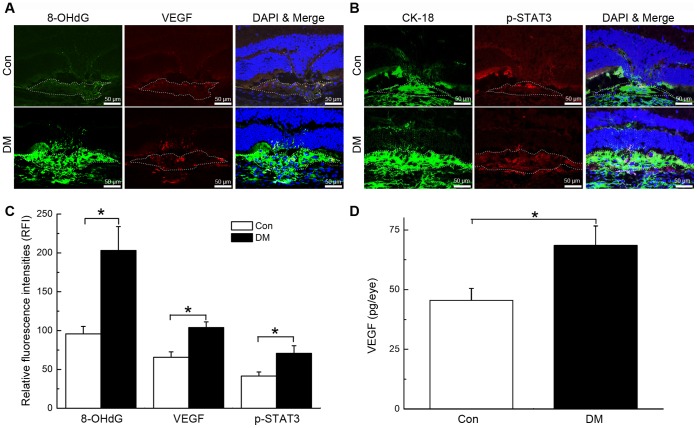
Hyperglycaemia resulted in the up-regulation of 8-OHdG, VEGF and p-STAT3 expression at sites of CNV.A-B, 8-OHdG, VEGF and p-STAT3 expression patterns at CNV sites in control (Con) and diabetic (DM) mice. CNV lesions were encircled with dashed lines. Relative fluorescence intensities (RFI) of targeted proteins were measured by analysing images of the immunofluorescence staining of serial cross sections of the eyecups. C, Statistical analysis of the data in A and B (*P<0.01); D, Statistical analysis of the data from the VEGF ELISA (*P<0.01).